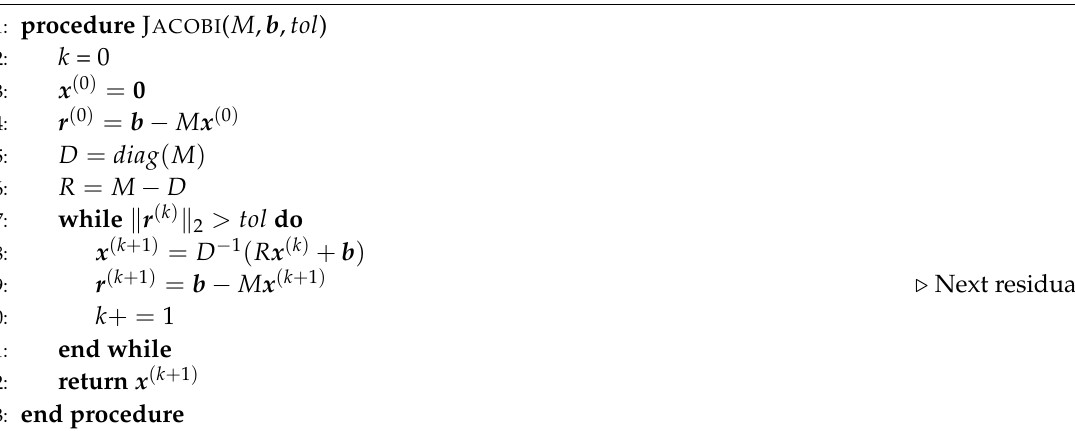
Algorithm 1 Solve M x = b to tolerance tol using Jacobi